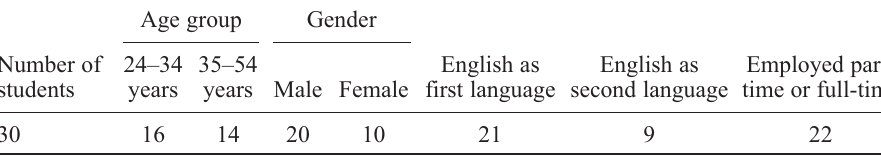
Table 1. Respondent characteristics